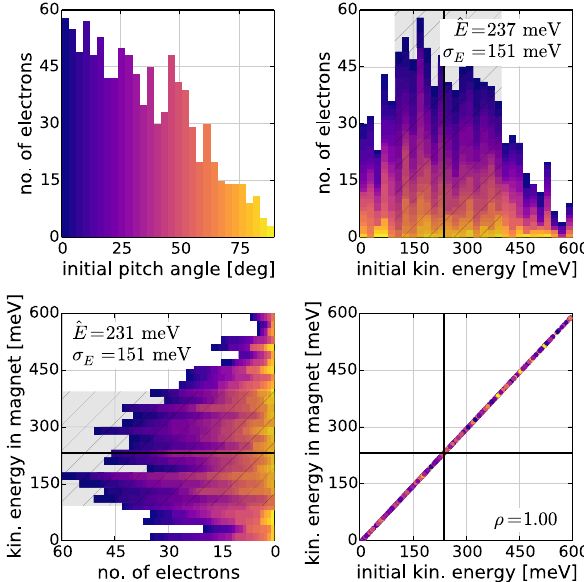
− 18 , 598 . 7V. The plot shows the initial energy distribution, E e , on the upper right ; the shifted energy distribution in the spectrometer entrance magnet, E = E kin + qU start , on the bottom left ; and the correlation between the two distributions on the bottom right . The initial energy E e corresponds to the start of the electron trajectory at 10nm distance from the photocathode. The distributions are colored by the initial pitch angle, which is cos θ -distributed as shown on the upper left . The median and the 1 σ -width of each distribution is indicated by the black lines and the shaded areas ,